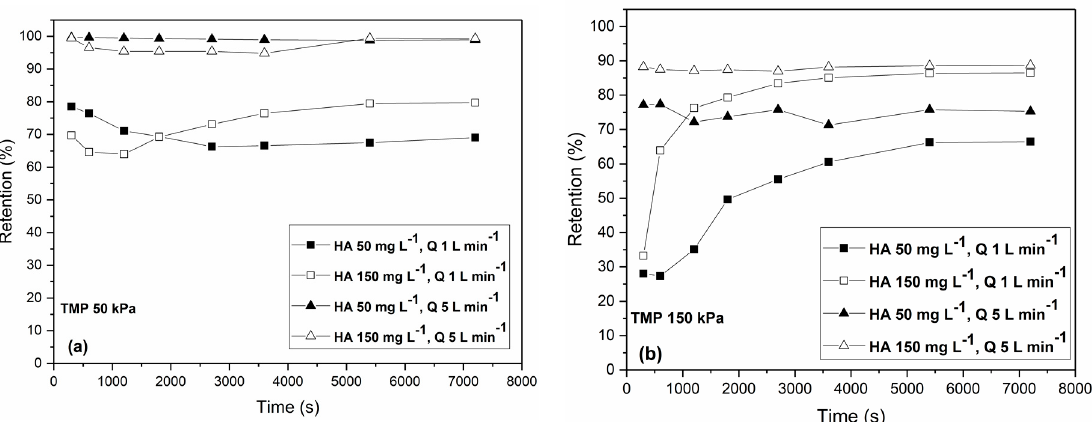
Figure 4. Time dependency of retention of humic acid at the different operating conditions: ( a ) transmembrane pressure of 50 kPa and ( b ) transmembrane pressure of 150 kPa. The concentrations of humic acid (50 and 150 mg L − 1 ) and the cross-flow rates (1 and 5 L min − 1 ) are varied.